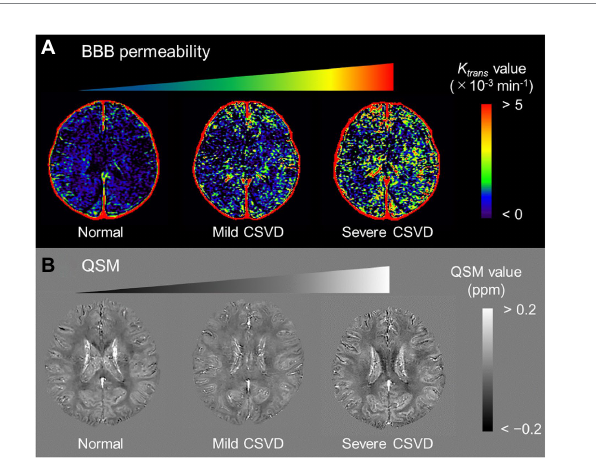
FIGURE 3 Representative BBB permeability K trans map (A) and QSM (B) from normal, mild CSVD, and severe CSVD. The K trans map from the severe CSVD displays the highest K trans values, which are associated with the highest susceptibility values. BBB, blood–brain barrier; CSVD, cerebral small vascular disease; QSM, quantitative susceptibility mapping [adapted with permission from Uchida et al.,